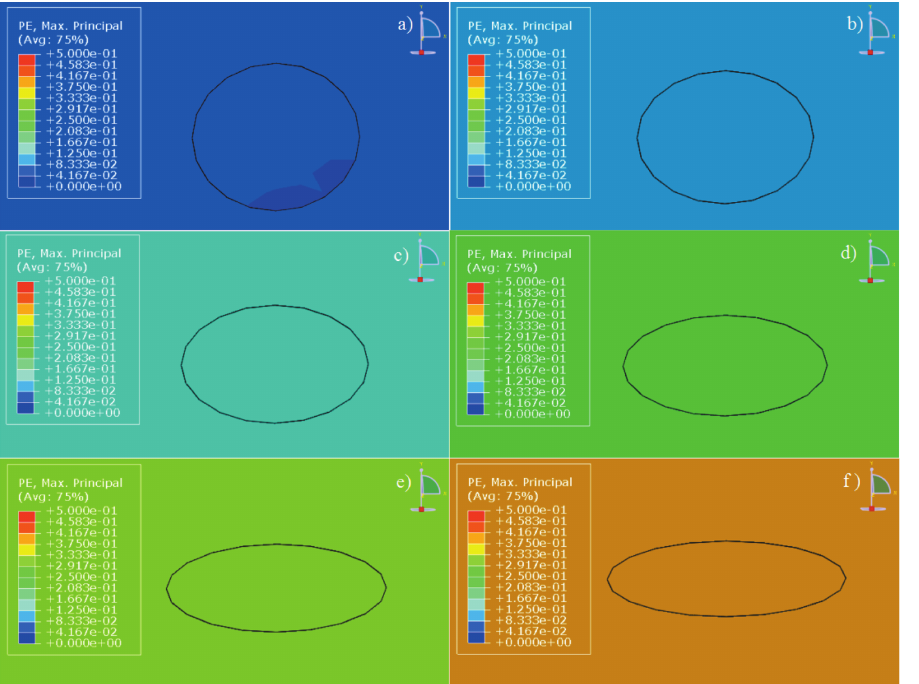
Figure 4: Plastic strain distribution of the soft inclusion after the following reductions at 800 ℃ : a) 10mm; b) 20mm; c) 30mm; d) 40mm; e) 50mm; f)